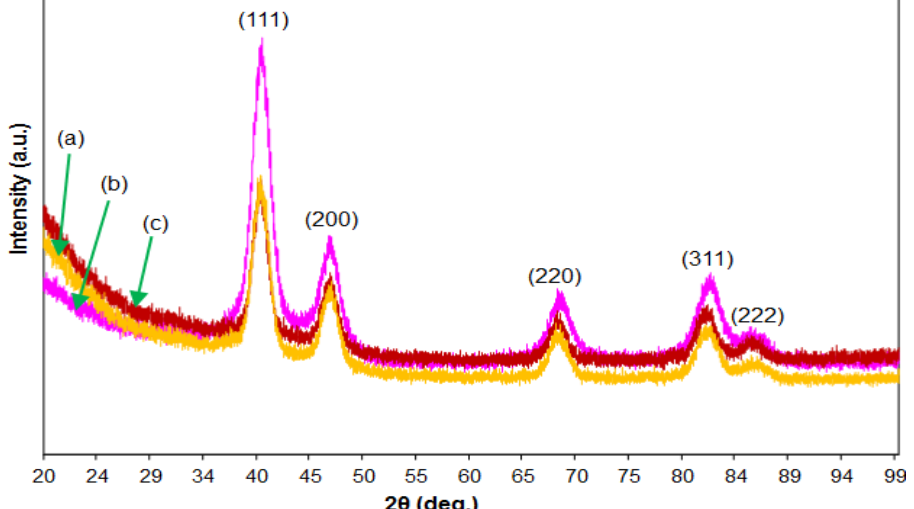
Figure 3. XRD patterns of PtM nanoparticles: ( a ) PtNi, ( b ) PtCo and ( c ) PtFe. Samples were deposited on an XRF microfine mylar polyester film on a flat sample